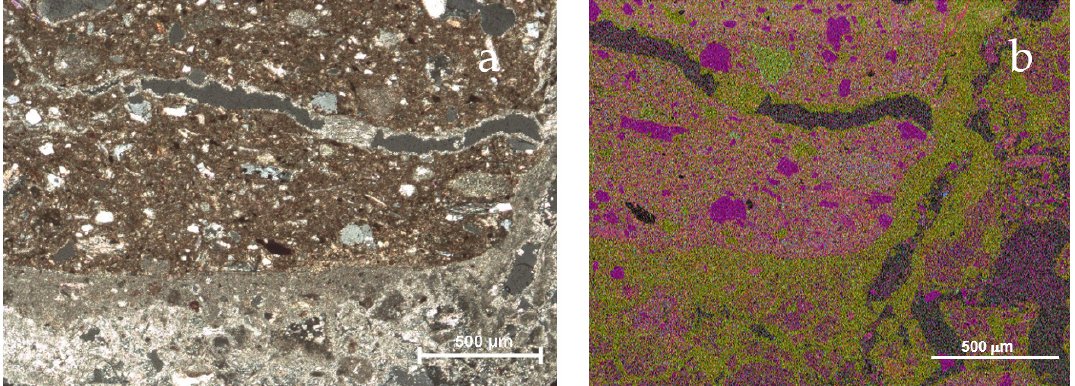
Figure 6. Microphotographs of crushed brick in a bedding mortar of the wall set against the cella in Building A of Sanctuary of Apollo, in Hierapolis archaeological site, Denizli (Turkey), Proto-Byzantine age under ( a ) PLM; xpl; and ( b ) EDS layered map of Ca, Si, Al, and Mg (Ca: yellow; Si: purple; Al: orange; Mg: light blue)